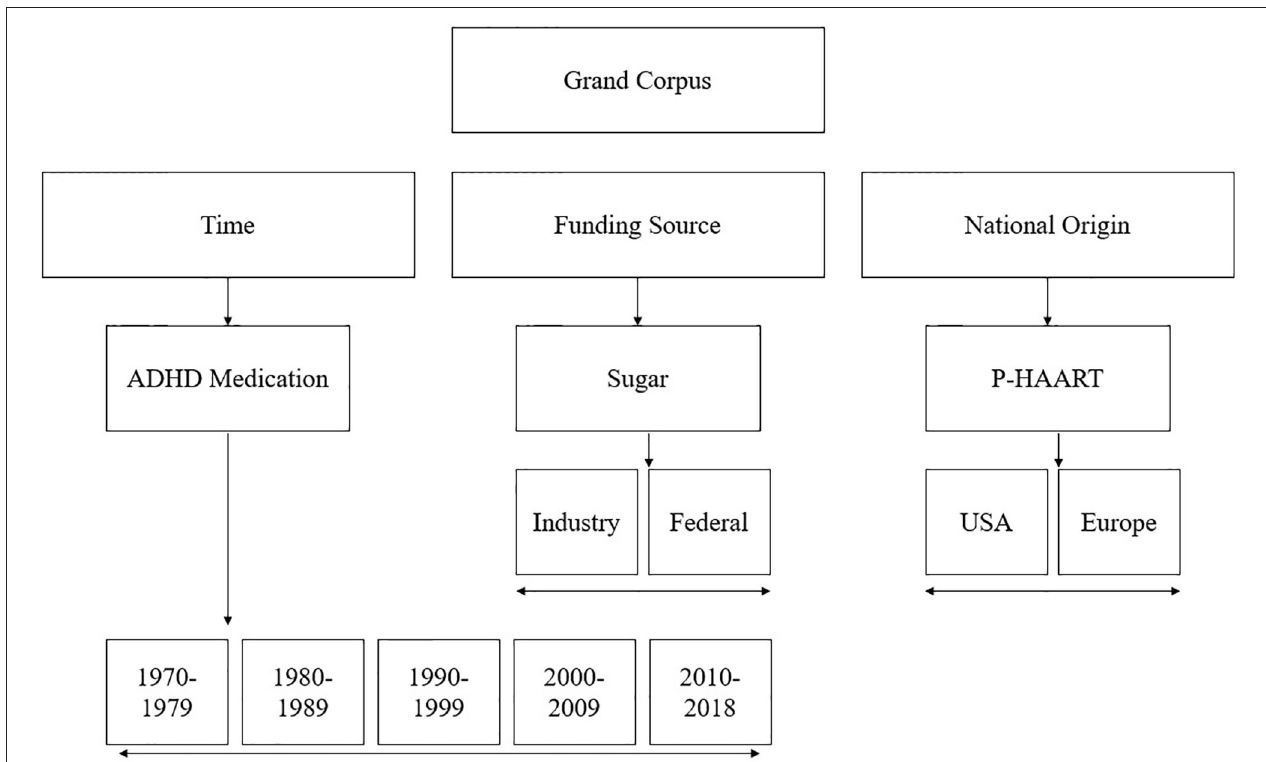
FIGURE 1 | A diagram denoting corpora